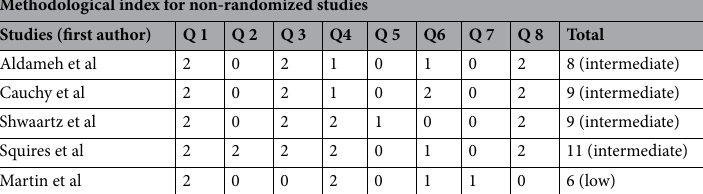
Methodological index for non-randomized studies